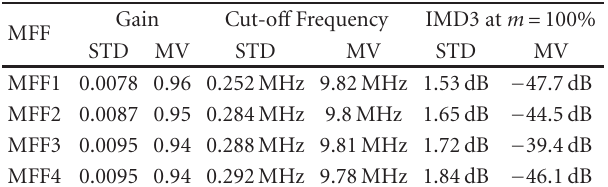
Table 4: Statistical simulation results about the frequency behav- iour of the LP filter functions of log-domain MFFs of Figure 6. Gain Cut-o ff Frequency IMD3 at m = 100% MFF STD MV STD MV STD MV MFF1 0.0078 0.96 0.252MHz 9.82MHz 1.53dB − 47.7 dB MFF2 0.0087 0.95 0.284MHz 9.8MHz 1.65dB − 44.5 dB MFF3 0.0095 0.94 0.288MHz 9.81MHz 1.72dB − 39.4